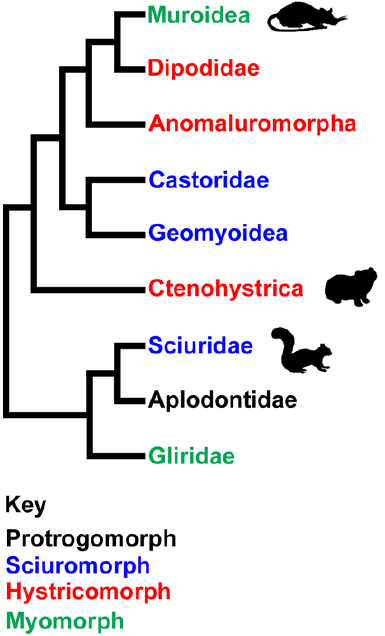
Figure 2. Simplified cladogram of the extant rodents showing the distribution of masticatory muscle morphologies. Topology based on Blanga-Kanfi et al [15]. Silhouettes indicate the position of the rat, guinea pig and squirrel within the Muroidea, Ctenohystrica and Sciuridae respectively.